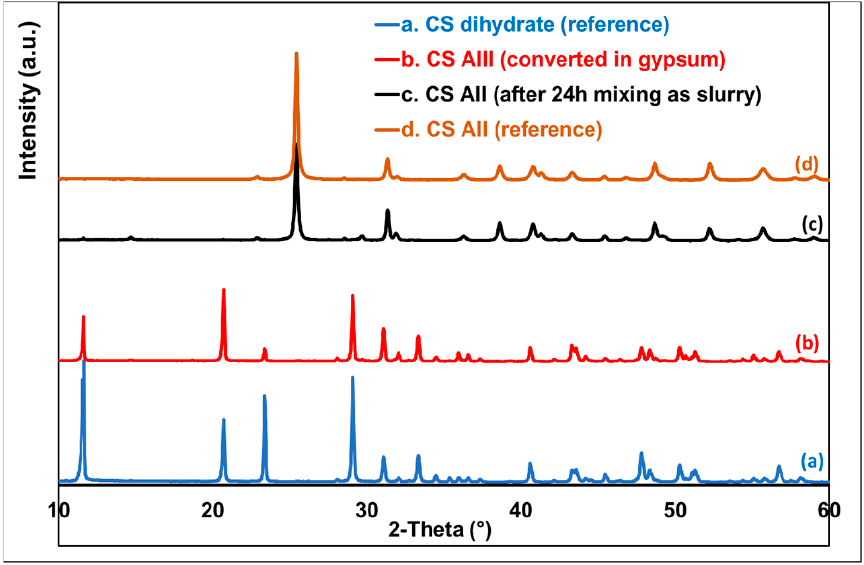
Figure 7. XRD patterns to evidence the stability of AII following the slurry